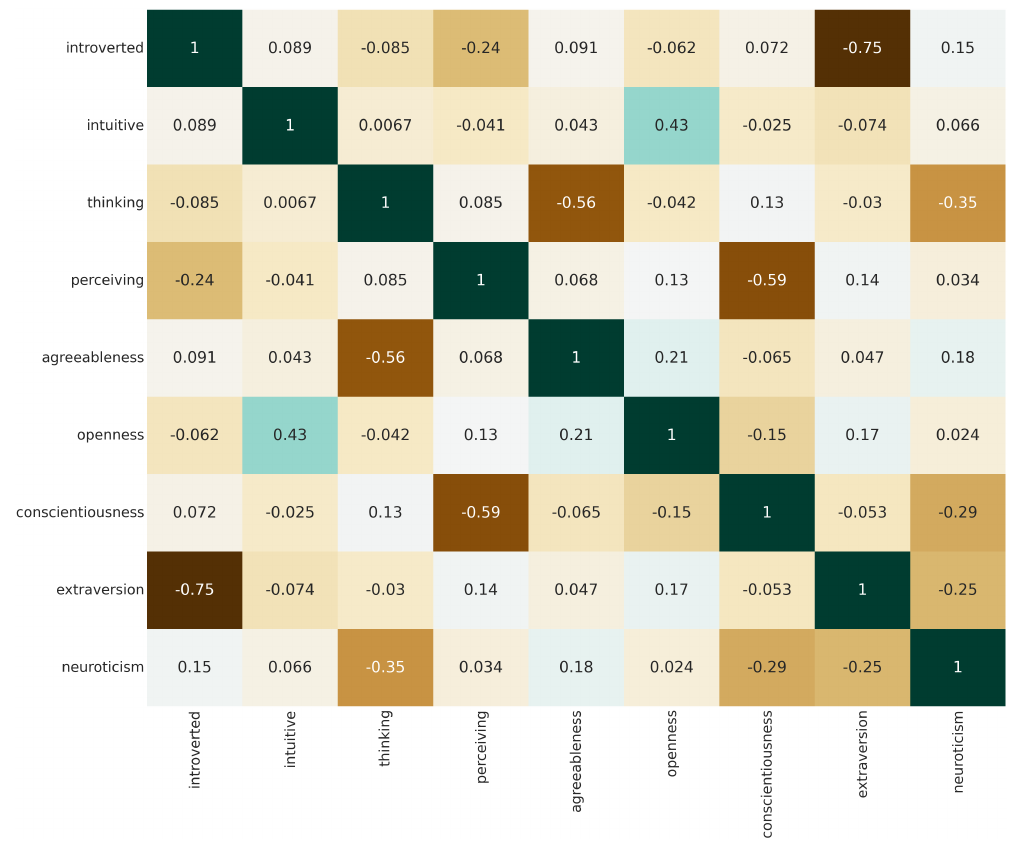
Figure 7. Heatmap indicating linear correlation between labels for the Big Five traits and MBTI types present in the PANDORA dataset